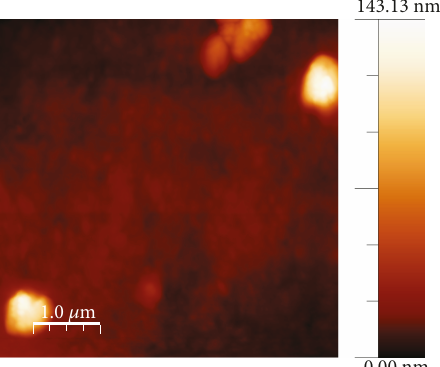
ZnPc fi lm on 4 CN calculated at the M06- 3 ZnPc, (t-Bu) ZnPc, and 4 4